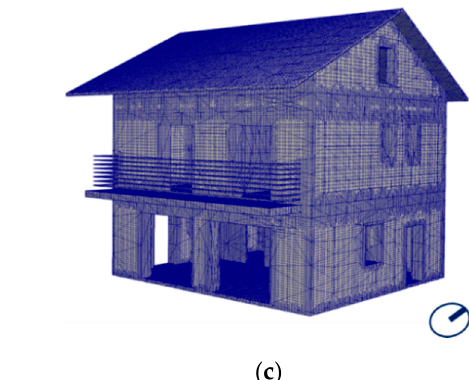
Table 2. Grid sensitivity with CFD 2.